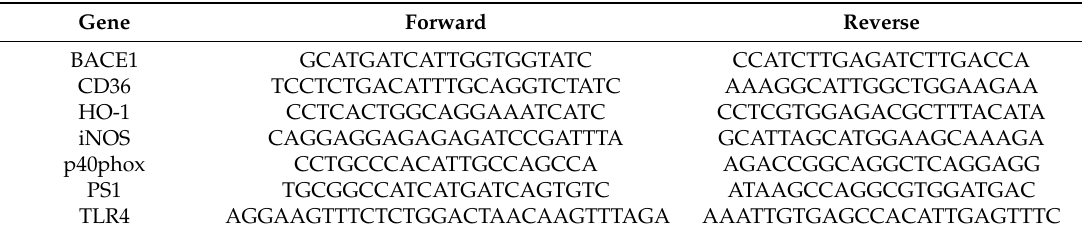
Table 1. Primer sequence for quantitative RT-PCR